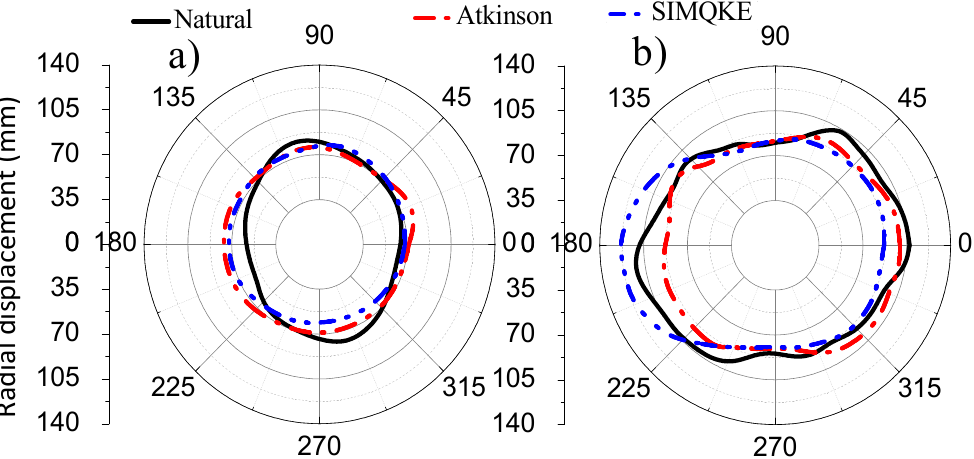
Figure 9. Mean displacements for column C2 in different radial directions: ( a ) regular bridge; ( b ) irregular bridge.